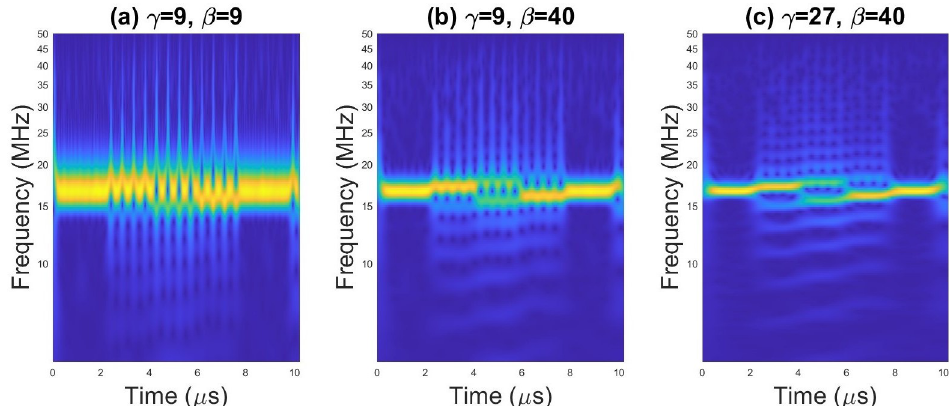
Figure 8. Scalogram for the pulse with Frank code for SNR = 20 dB.